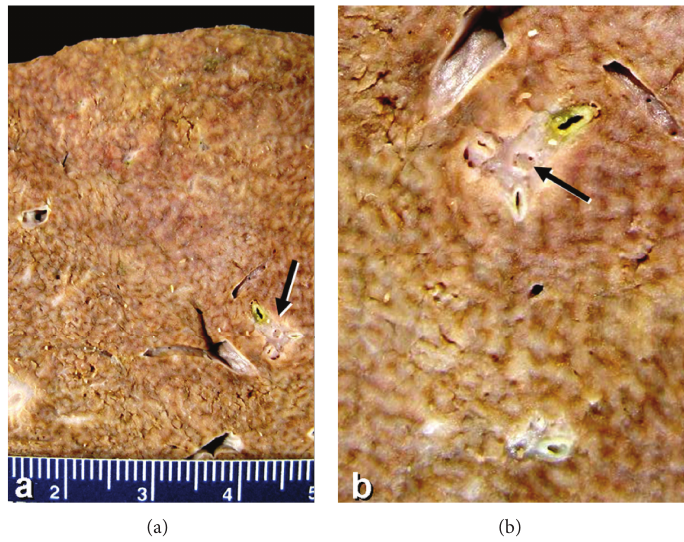
Figure 2: (a) Postmortem liver with nodular regenerative hyperplasia (NRH). The cut surface demonstrates small nodules < 3mm in size without surrounding fibrosis. The portal tract at the arrow is enlarged in (b). The ruler is in centimeters. (b) The small regenerative nodules of NRH are apparent. The portal tract at center shows a putty-like tumor thrombus of breast carcinoma within the portal vein branch (arrow).